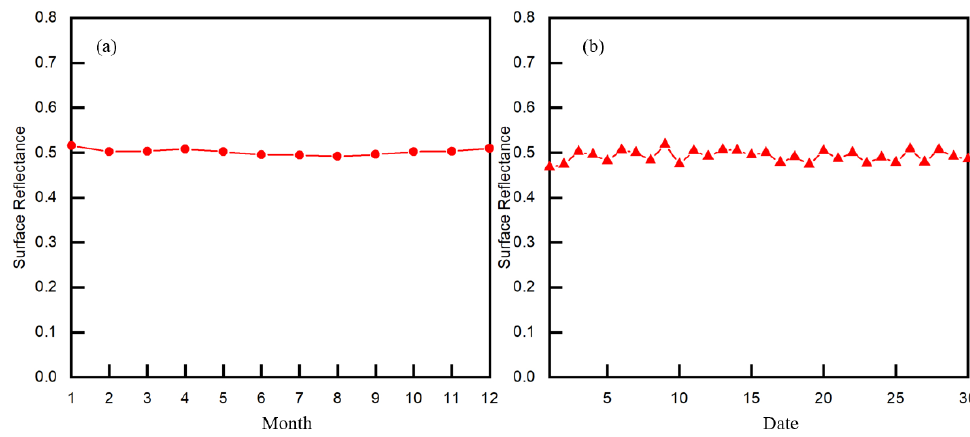
Figure 7. ( a ) Surface reflectance of the Kufra, Libya site in 2018. ( b ) Surface reflectance of the Kufra, Libya site in July 2018.( red circle represents the monthly average result, red trangle represents the daily average results)